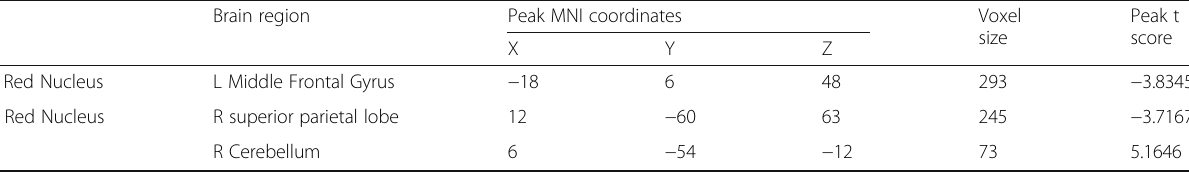
Table 2 Abnormal functional connectivity of the bilateral red nucleus in patients with MwoA compared with healthy